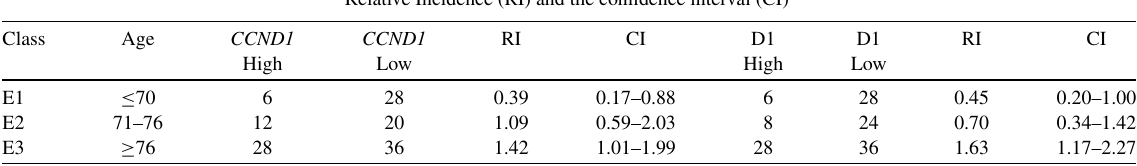
Relative Incidence (RI) and the confidence interval (CI)